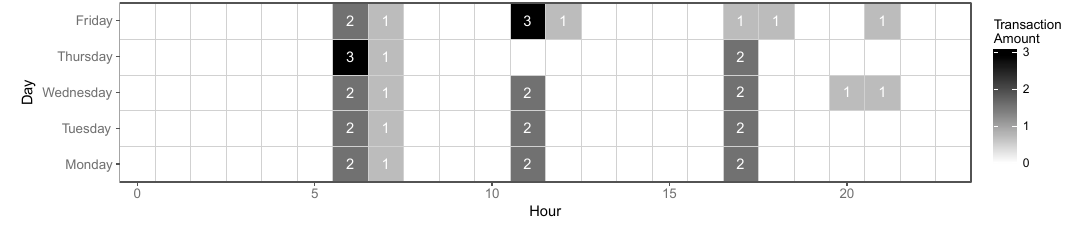
Figure 4. An example boarding time profile.